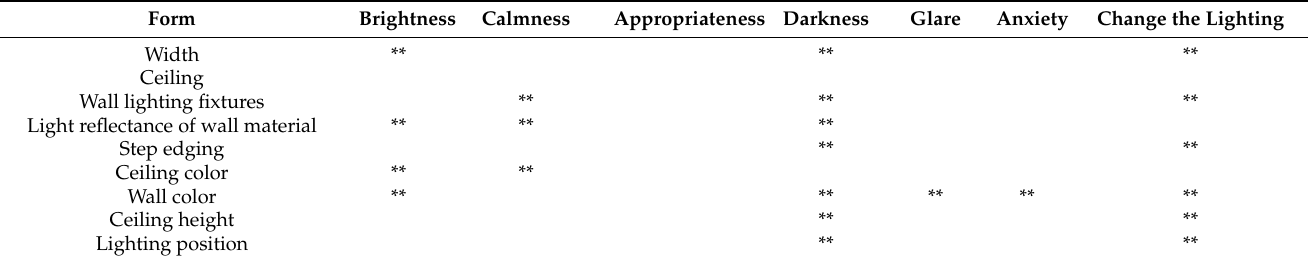
Table 5. ANOVA results according to stair type classification (** significant difference).